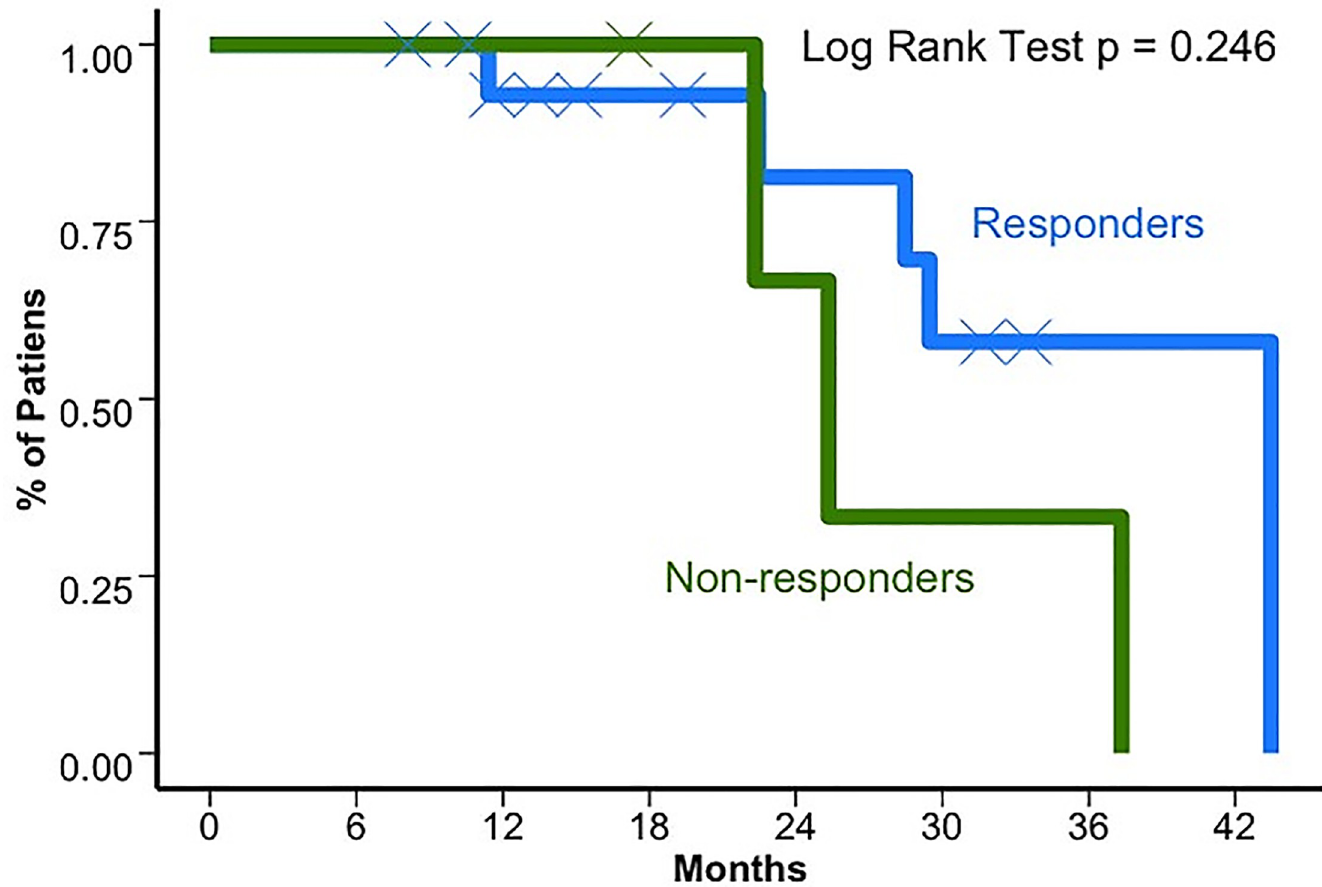
Fig 3. Overall survival based on response to first line therapy. For responders and non-responders OS were 43.5 (95%CI 28.5-NR) and 25.3 (95%CI 22.3-NR) months, respectively.